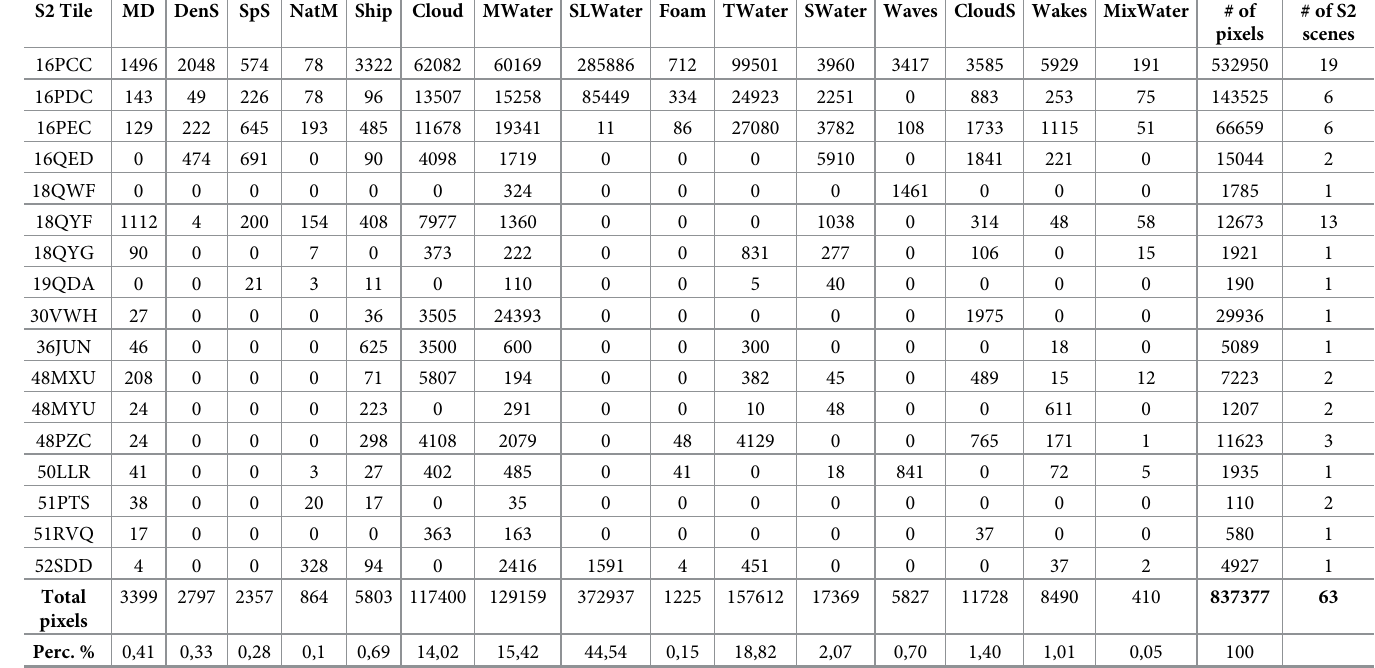
Table 3. MARIDA’s class distribution at pixel-level. For Sentinel-2 tiles description, the reader is referred to Table 1. For classes acronyms, the reader is referred to Table 2. S2 Tile